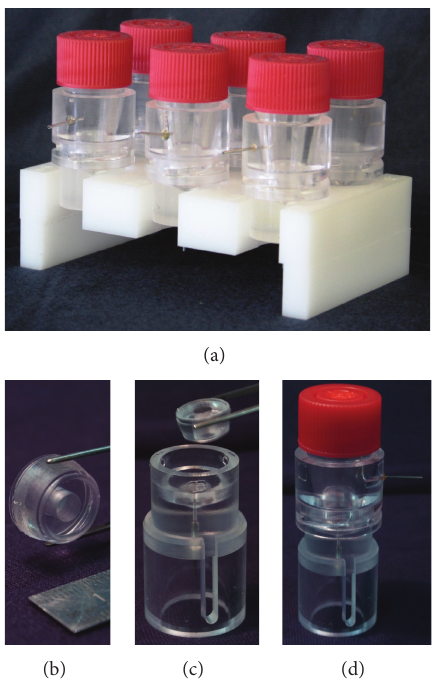
Figure 4: The 6-chamber bioreactor hosted in a support made of polyoxymethylene, with a planar size of a multiwell-plate (a). Detail of a scaffold holder cartridge with a 5.5 mm opening diameter; the upper and lower gaskets can be appreciated (b). The scaffold holder cartridge is fitted into the housing (c), which is topped by a reservoir element through a fast bayonet coupling (d). Table 1: Data related to microbiological analyses performed to check for contamination of the culture medium collected from each sterility maintenance experiment Neg.: negative result (i.e., zero colonies found). For the test configurations refer to Figure